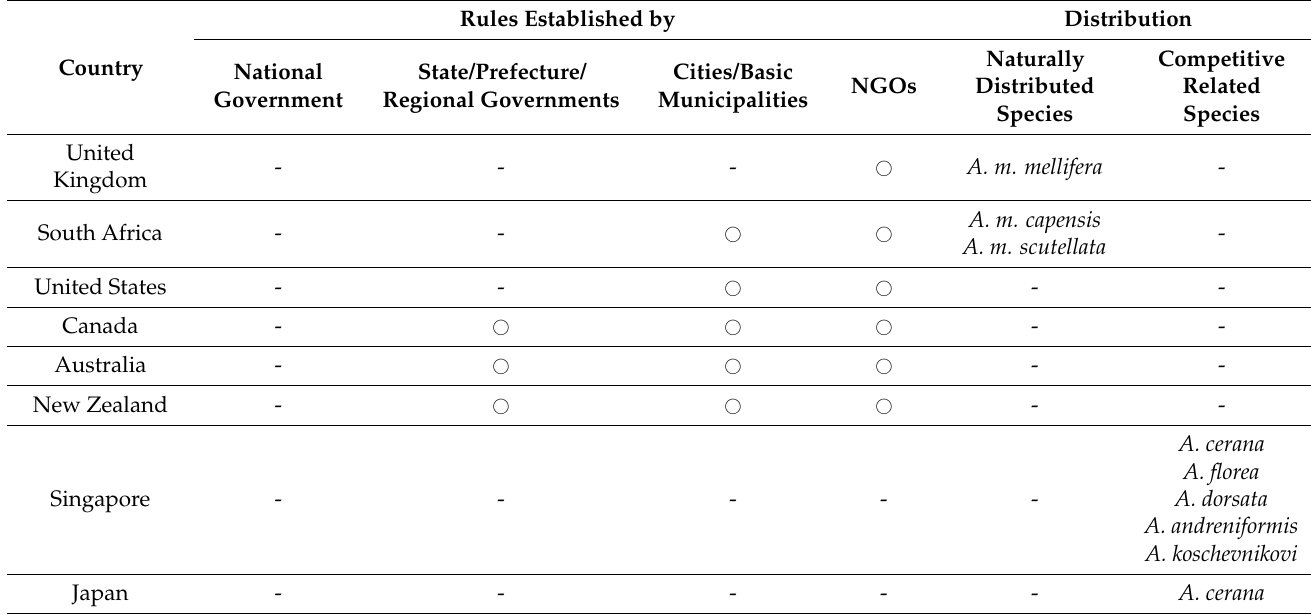
Table 4. Existence of urban beekeeping rules and distribution of Apis mellifera and competing related native species. “-” means N/A and “ ” represents the existence of a rule document developed by the relevant organization. (cid:35) Rules Established by Distribution Competitive Naturally Country National State/Prefecture/ Cities/Basic Related NGOs Distributed Government Regional Governments Municipalities Species